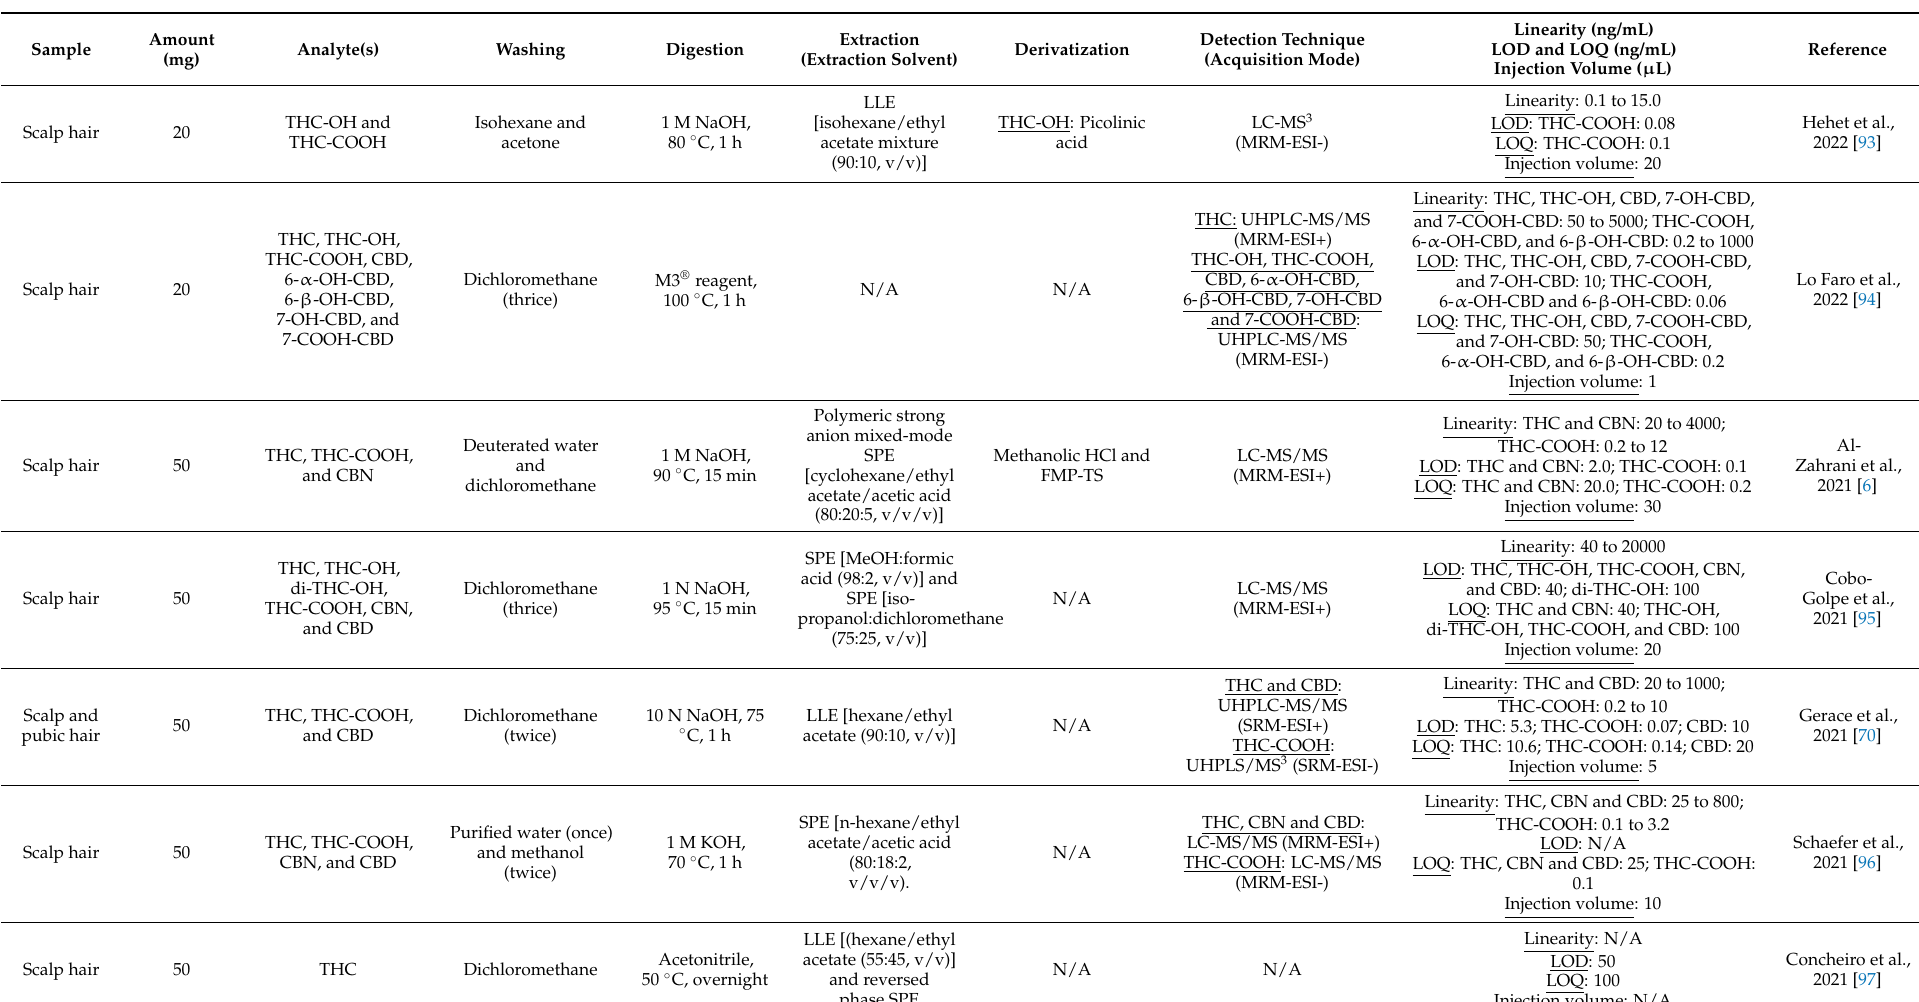
Table 5. Methods for the identification and quantification of cannabinoids in